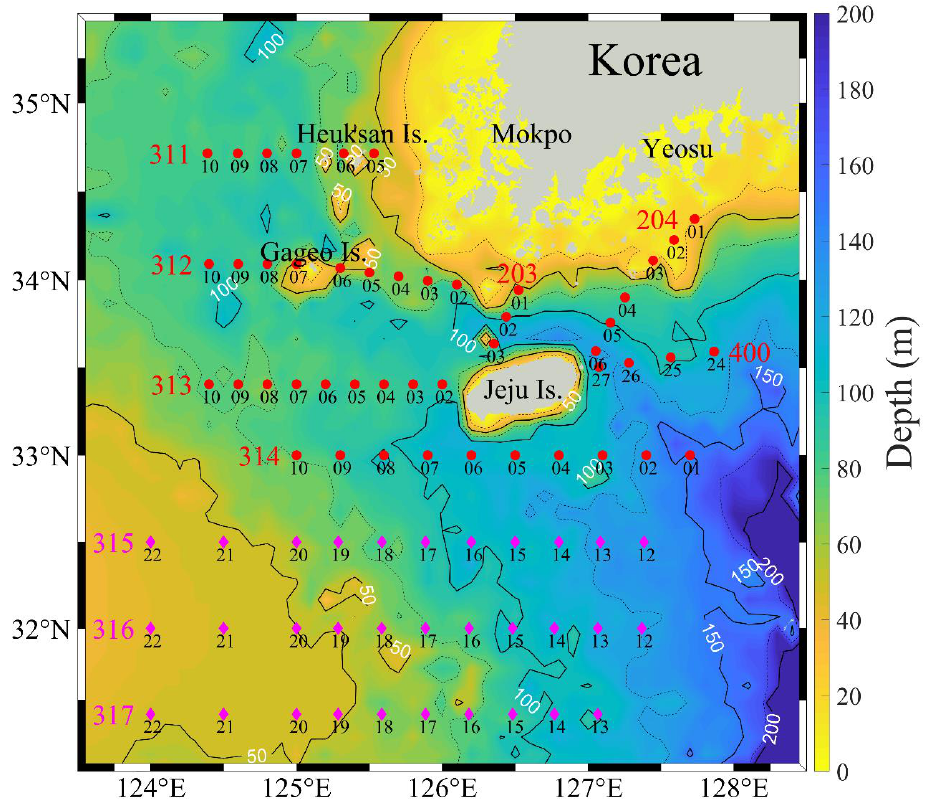
Figure 1. Station of the water temperature inversion layer (TIL) behavior analysis in the Northern East China Sea Island during 1995–2016. Red stations were observed in February, April, June, August, October, and December. Magenta stations were observed in February, May, August, and November. Black number is station of observation transect. The black line (dot line and white number) is bathymetry